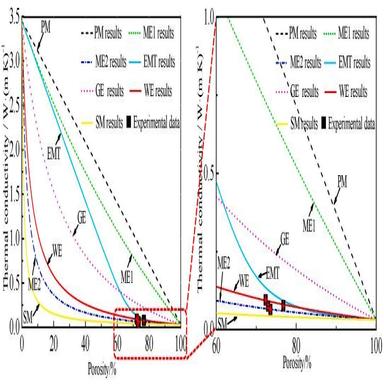
Heat conductivity of lightweight porous materials with different porosities.